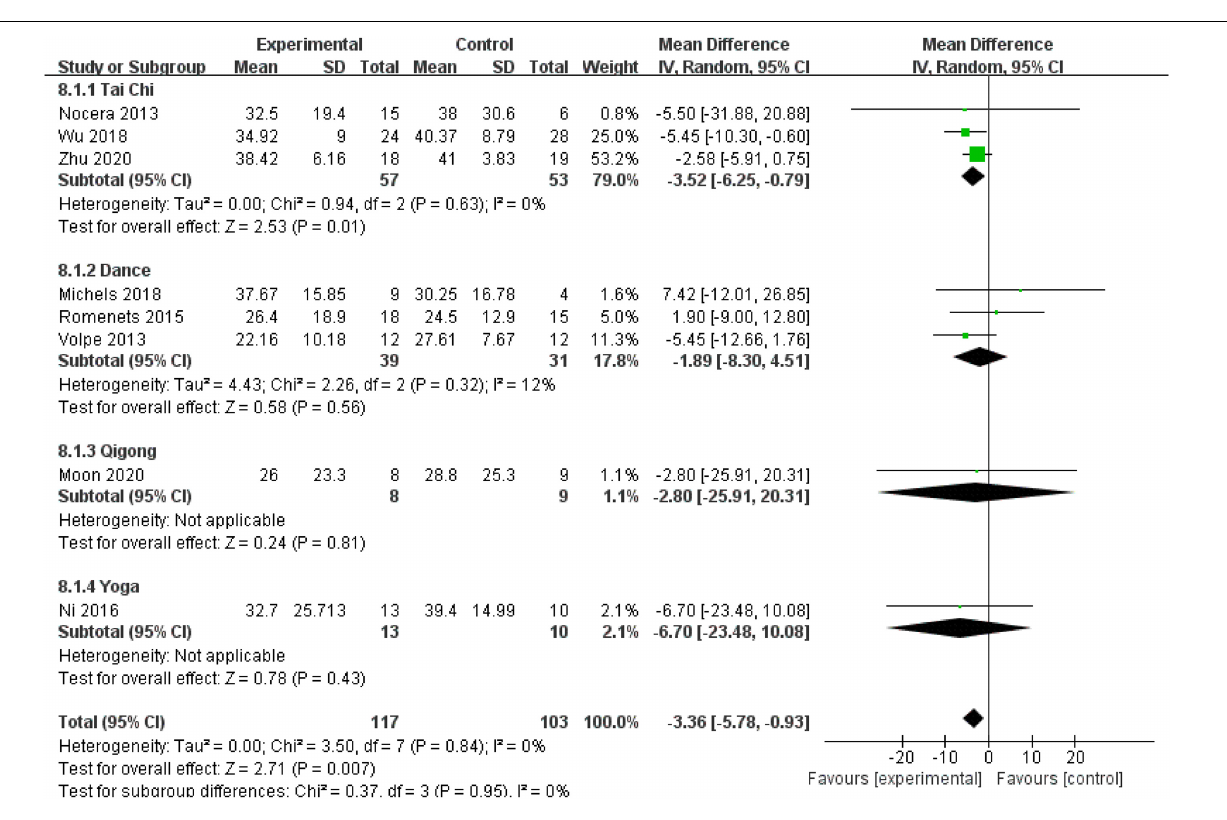
FIGURE 8 | Forest plot showing the effects of mind–body exercises on quality of life.